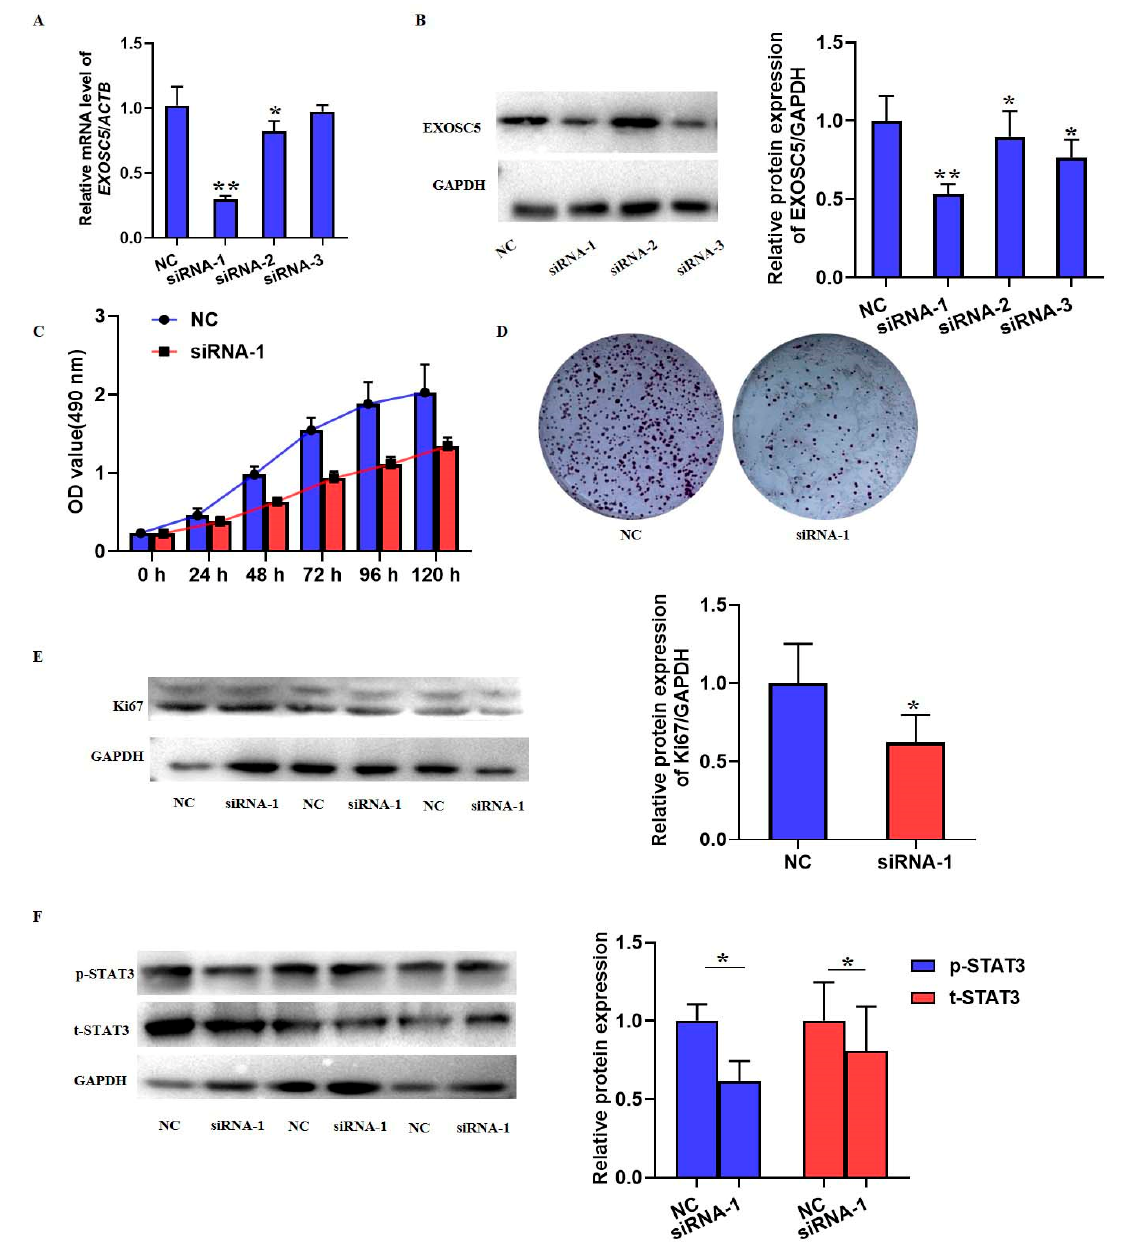
Figure 10. EXOSC5 was related to the cell growth in HCC cells. Three pairs of EXOSC5 siRNAs (siRNA-1, -2 and -3) with different binding sites were employed to silence EXOSC5 in SMMC7721 cells. ( A ) qPCR was performed to detect the mRNA levels of EXOSC5. ( B ) Western blotting was performed to detect the protein levels of EXOSC5. ( C ) MTT assay and ( D ) colony formation assay were used to monitor the cell growth of SMMC7721 cells transfected with EXOSC5 siRNA-1 and the control for the consecutive culture of 120 h. ( E ) The protein expression of Ki67 was detected by western blot. ( F ) The total and phosphorylated STAT3 proteins levels were detected by western blot. Image J software was used to analyze the relative levels of proteins normalized to the expression of GAPDH. * p < 0.05, ** p < 0.01, compared with its relative control. To further confirm the role of activated STAT3 in HCC, we assayed the protein levels of STAT3 in HCC and adjacent tissues. Figure 11A,B showed the upregulated expression of STAT3 in HCC tissue and cell lines. We then chose the specific inhibitor, S31-201, to treat SMMC7721 cells. As shown in Figure 11C,D, S31-201 did not influence the mRNA